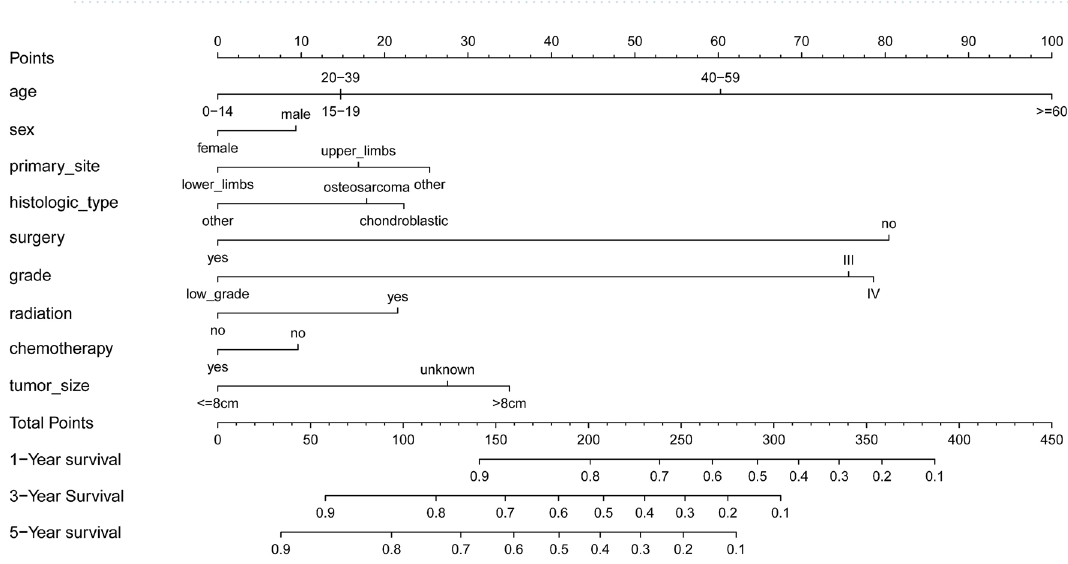
Figure 5. Calibration curves for 1- ( A ), 3- ( B ) and 5-year ( C ) survival. Calibration curves depict the calibration of each model in terms of the agreement between the predicted probabilities and observed outcomes of the training set.